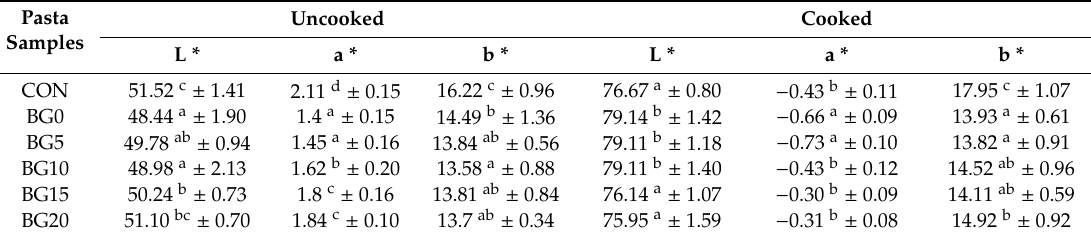
Table 6. Color parameters of cooked and uncooked pasta samples. Pasta